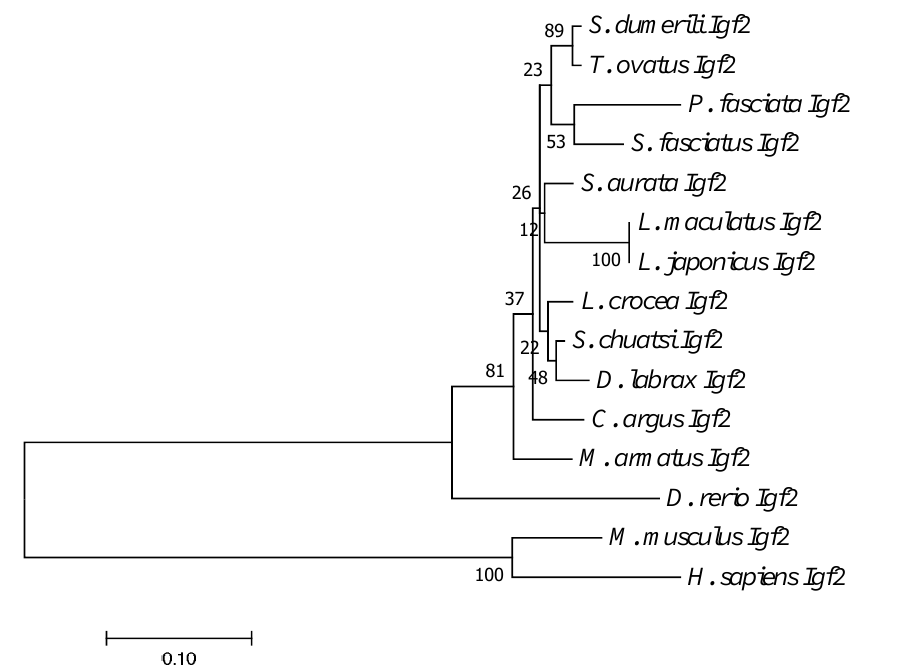
Figure 4. Phylogenetic tree based on the amino acid sequence of IGF2. The accession numbers for sequences are shown in Table 2. Table 2. IGF2 sequence of each species used in this